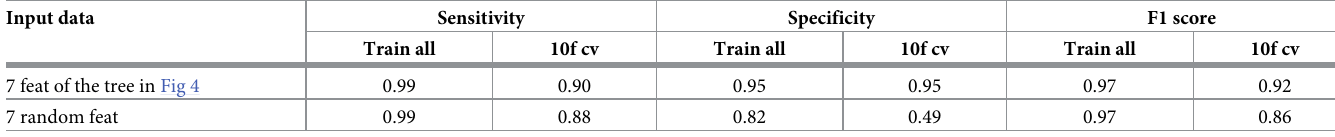
Table 4. BDT performance evaluation. Comparison between the performance of the classifier developed in this study and classifiers trained on a random set of 7 features. The results of the permutation tests are the average of those obtained from 1,000 permutations. Input data Sensitivity Specificity F1 score Train all 10f